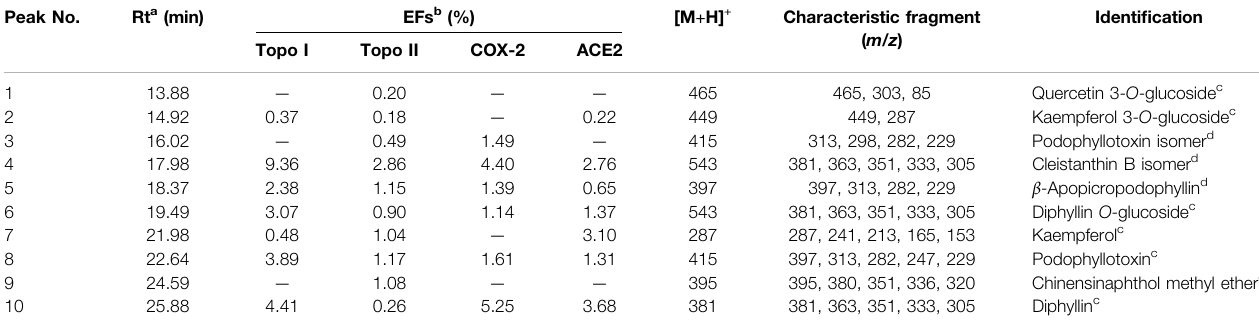
TABLE 1 | EFs and the UF – LC/MS data of the bioactive compounds bound to Topo I, Topo II, COX-2, and ACE2 from the crude extracts of P. sinense . Peak